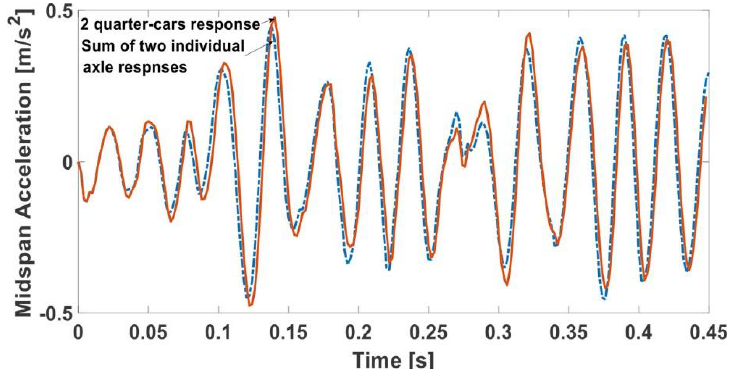
Figure 4. Bridge acceleration response to a two quarter-car vehicle and sum of the individual axle responses using the class ‘A’ road profile.